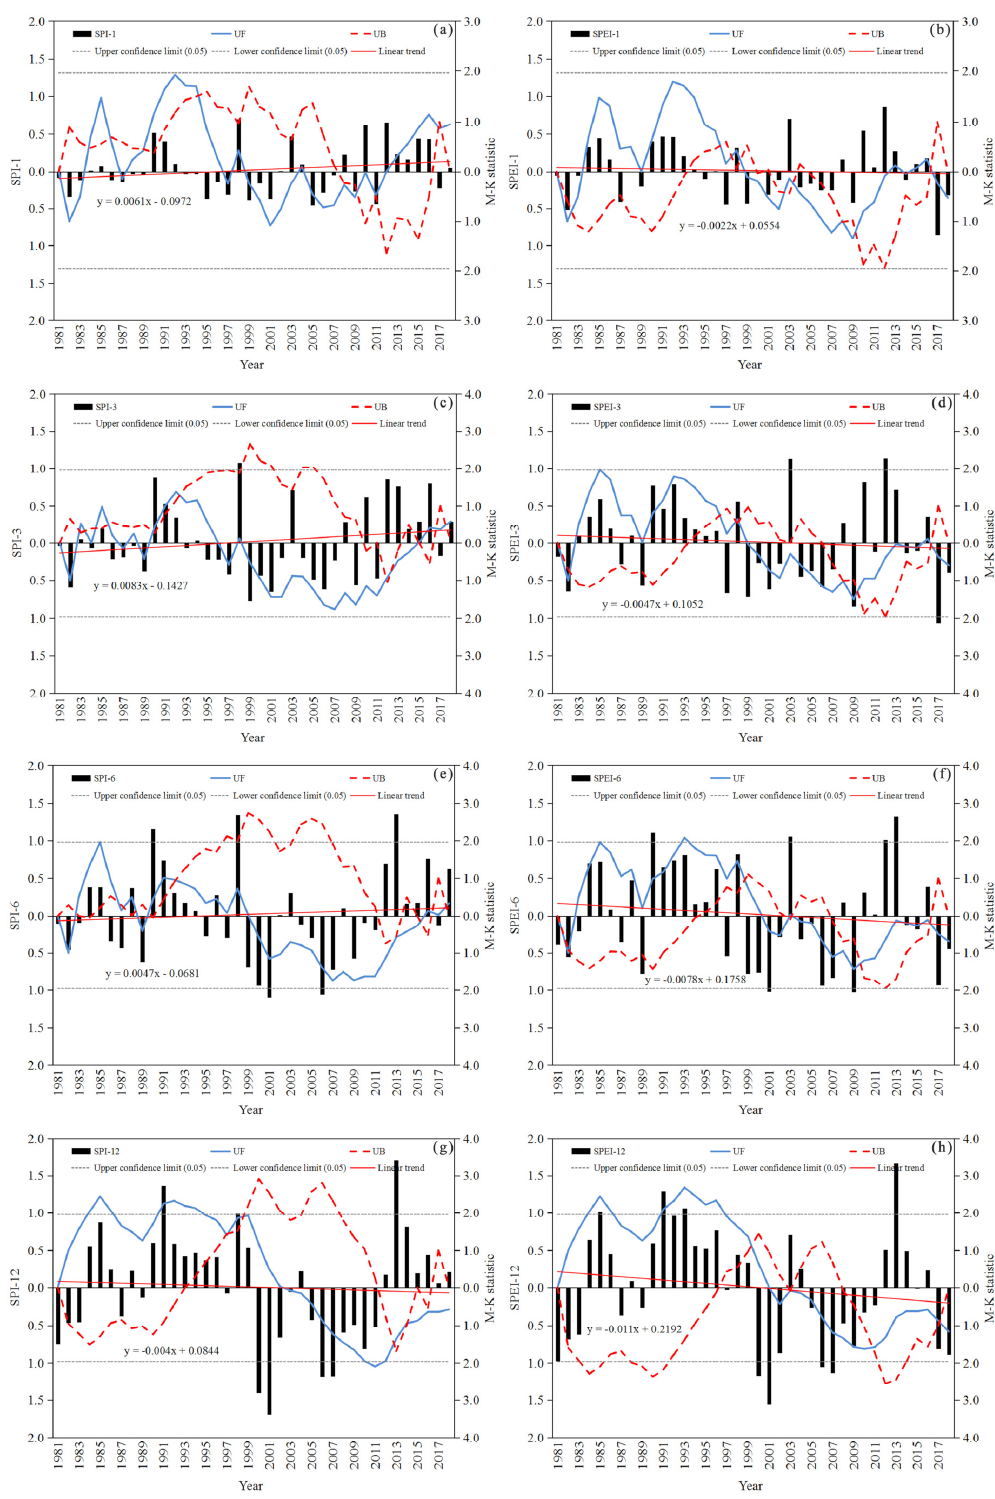
Figure 4. Annual variations, linear trends, and abrupt changes in the SPI and SPEI at 1-, 3-, 6-, and 12-month timescales in Inner Mongolia during 1981–2018. SPI: ( a ) 1-month, ( c ) 3-month, ( e ) 6-month and ( g ) 12-month timescales; SPEI: ( b ) 1-month, ( d ) 3-month, ( f ) 6-month and ( h ) 12-month timescales.